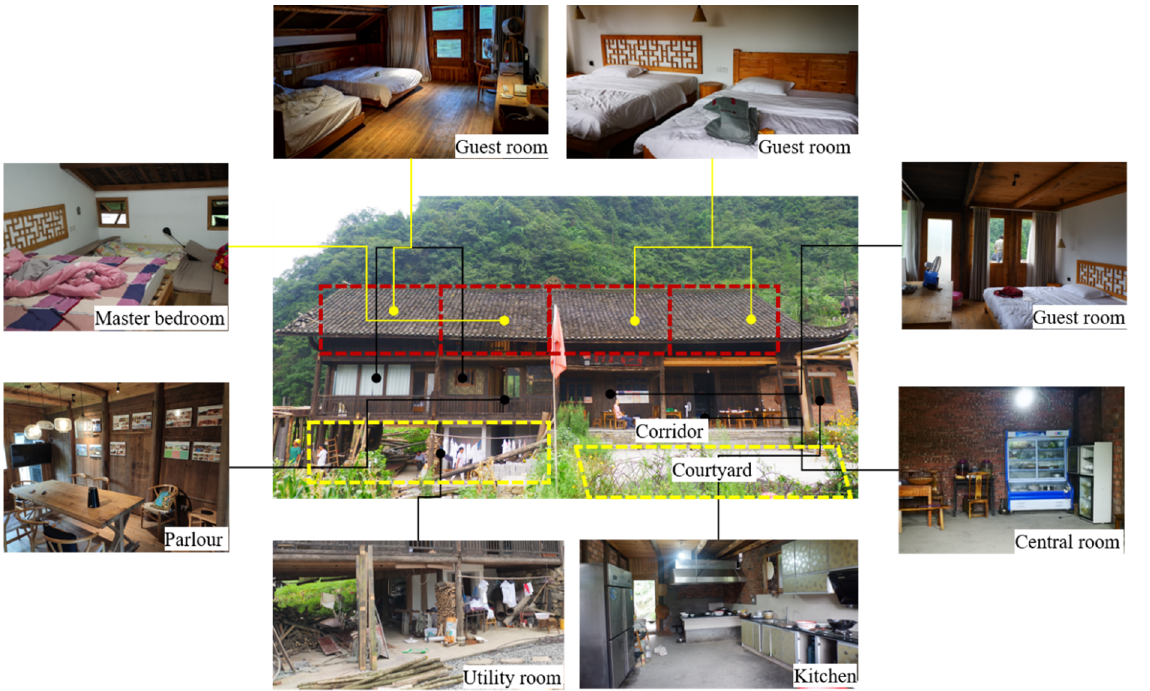
Figure 6. The internal structure and functional layout of the homestead after the operation of the homestay in Xiniu village.